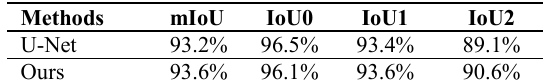
Table 4 . Performance comparison on the test dataset.